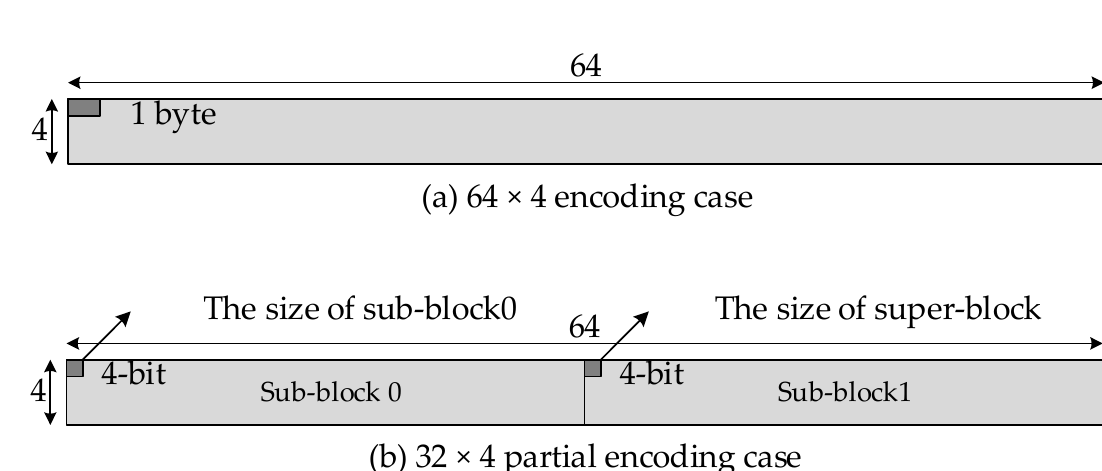
Figure 5. Metadata structure: ( a ) 64 × 4 encoding case; ( b ) 32 × 4 encoding case.